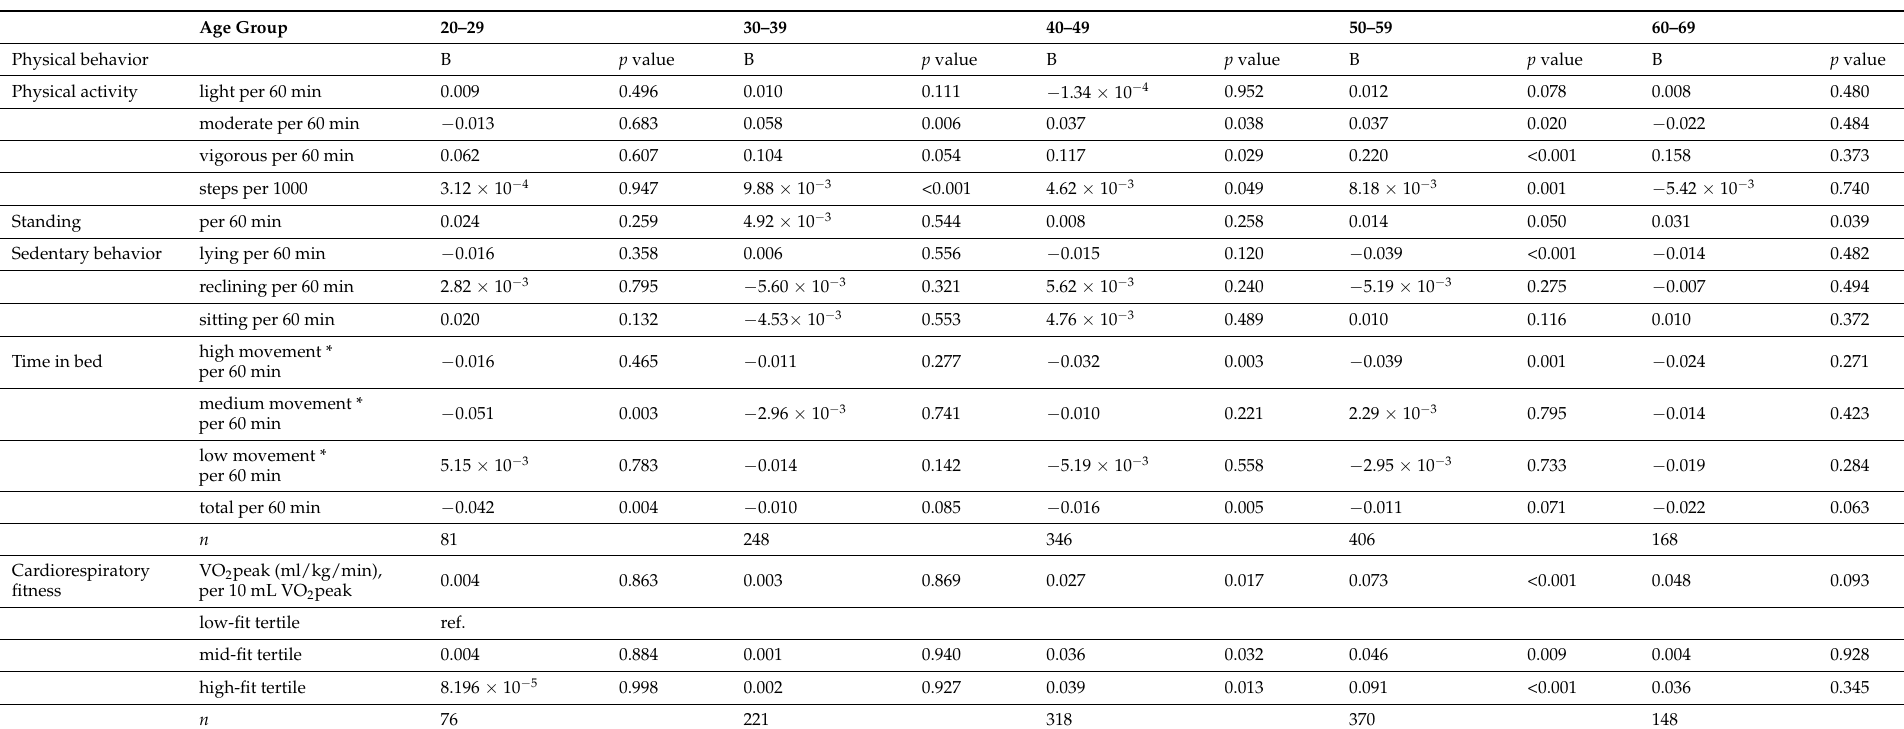
Table 3. Gamma regression on the age-group-specific association between physical behavior and work ability (sWAI) adjusted for sex, education, and physical work